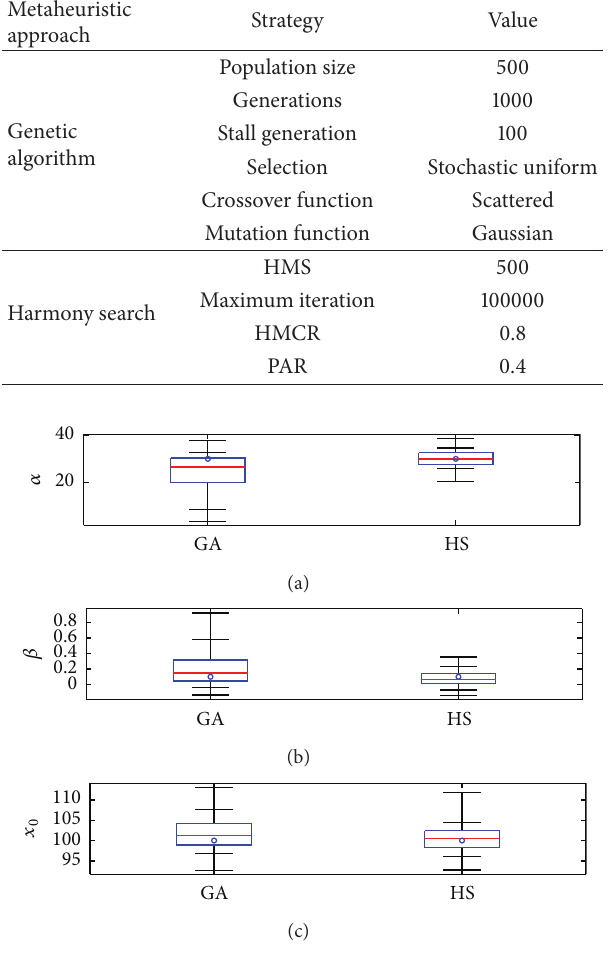
Figure 2: Boxplots of estimated GEV parameters using 100 sim- ulations based on GA and HS; (a) scale parameter, 𝛼 ; (b) shape parameter, 𝛽 ; and (c) location parameter, 𝑥 0 .